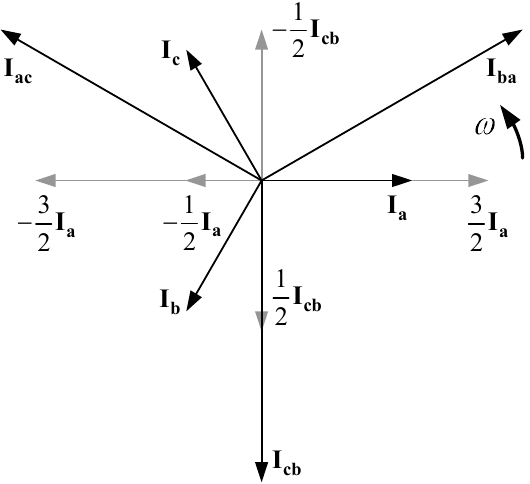
Figure 2. Electric current phasor representation in the I a – I cb reference system. (a) Phasor representation of the phase currents.